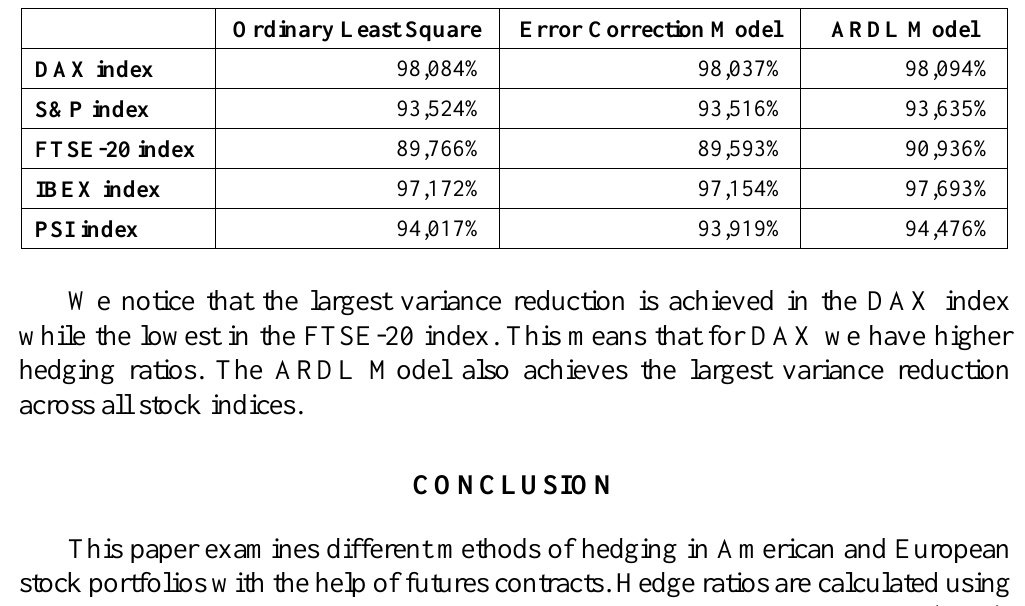
Table 4. Hedging effectiveness